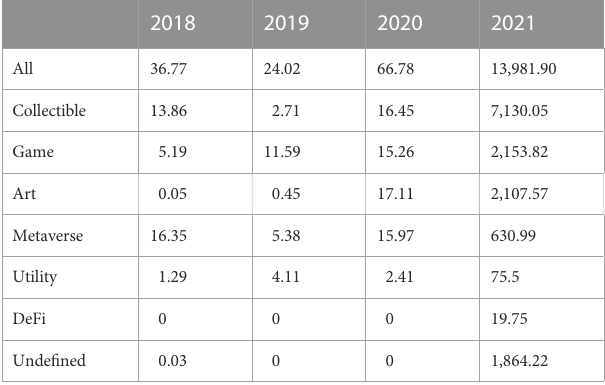
TABLE 2 Composition of NFT sales, by major